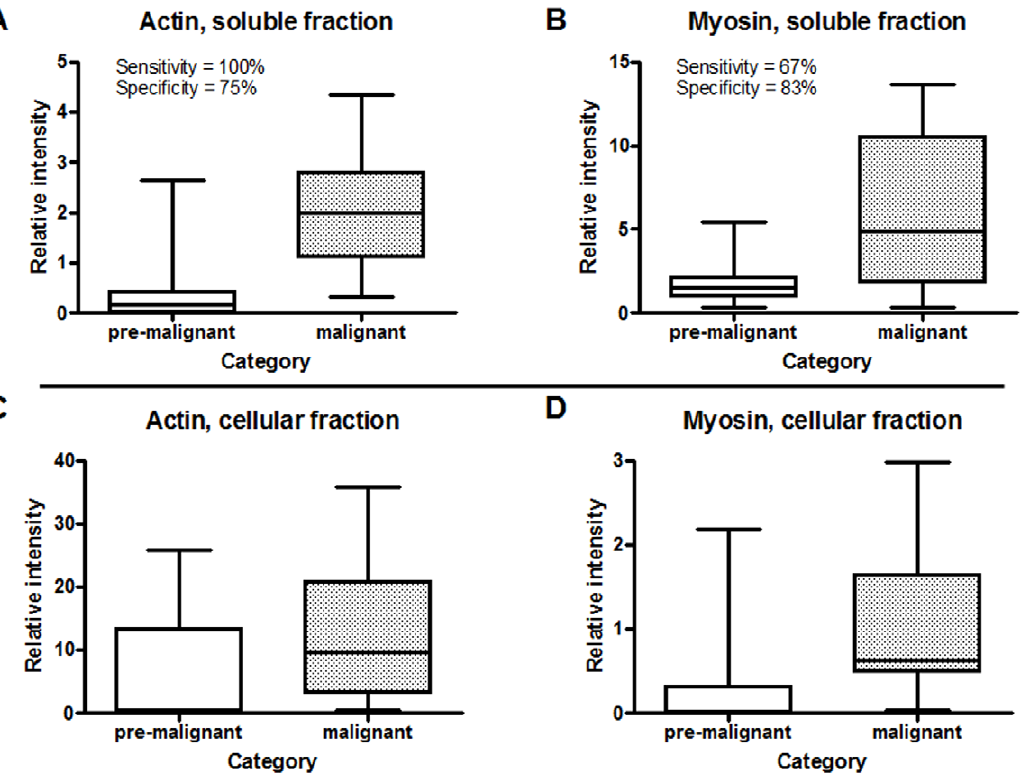
Figure 3. Summary of western blot validation results. Box plots of actin and myosin western blot data in soluble saliva (panels A and B, mean of twelve samples tested in each subject group; the ratio for each sample being the mean of three technical replicates) and exfoliated cells in the same saliva samples (panels C and D, mean of twelve samples tested in each subject group). Each plot displays the median (solid horizontal line within each box), quartiles (area if each box), and range of the data (bars extending from each box). Western blots were performed for actin (A, C) and myosin (B, D).